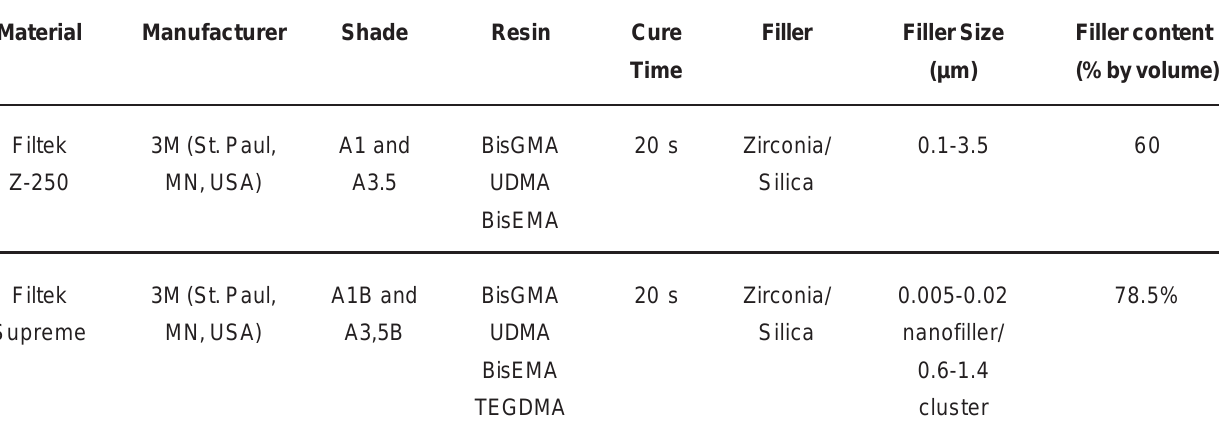
TABLE 1- Tested materials and their technical